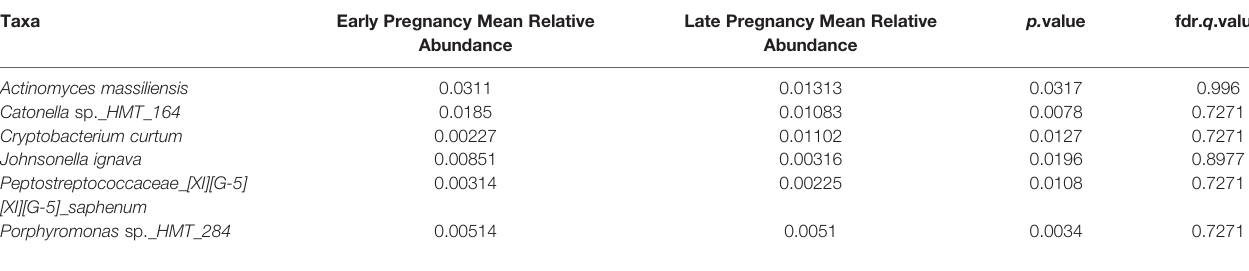
p. Late Pregnancy Mean Relative Abundance Abundance